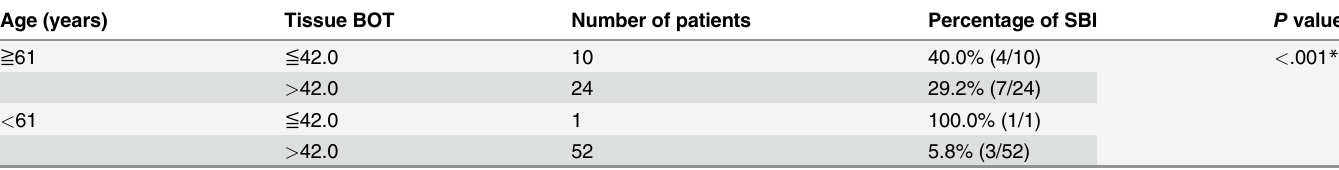
Table 4. Association of silent brain infarction with age and laser speckle fl owgraphy fi ndings. Age